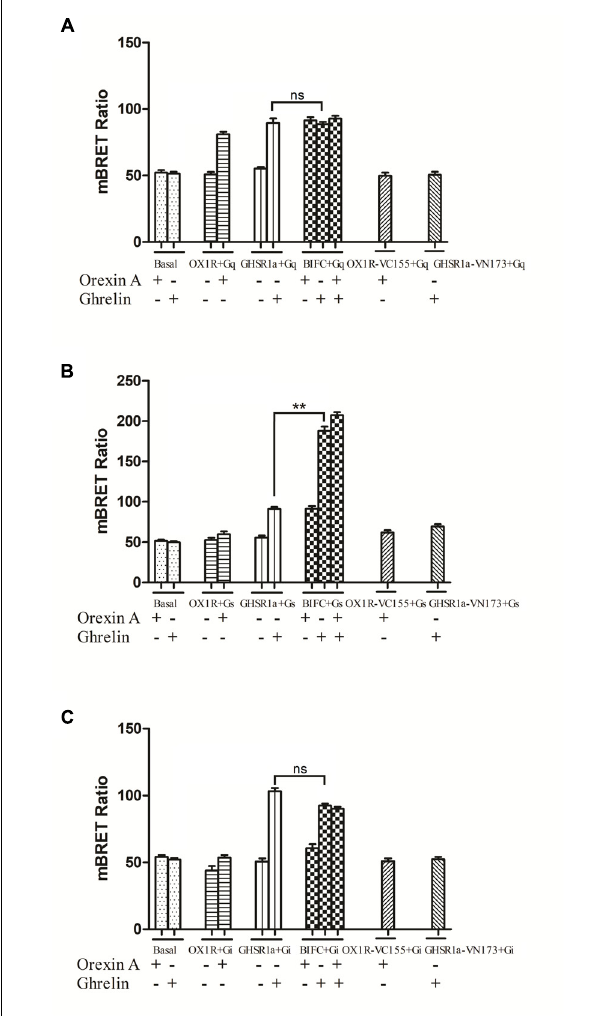
FIGURE 7 | Bioluminescence resonance energy transfer analysis of the effects of GHSR1a/OX1R heterodimerization on G α protein subunit activation. HEK293 cells expressing GHSR1a, OX1R or BIFC (GHSR1a/OX1R) were stimulated with 100 nM ghrelin and/or 100 nM orexin-A for 20 min, and analysis of the interaction between GHSR1a/OX1R heterodimers and (A) G α q-Rluc8, (B) G α s-Rluc8, and (C) G α i2-Rluc8 was performed using BRET. ∗∗ p < 0.01, HEK293 cells co-expressing GHSR1a/OX1R stimulated with ghrelin (100 nM) vs. HEK293 cells expressing GHSR1a only;. The data points represent the mean ± SEM ( N = 3) of four independent experiments. ns, not significant, as determined by two independent samples t